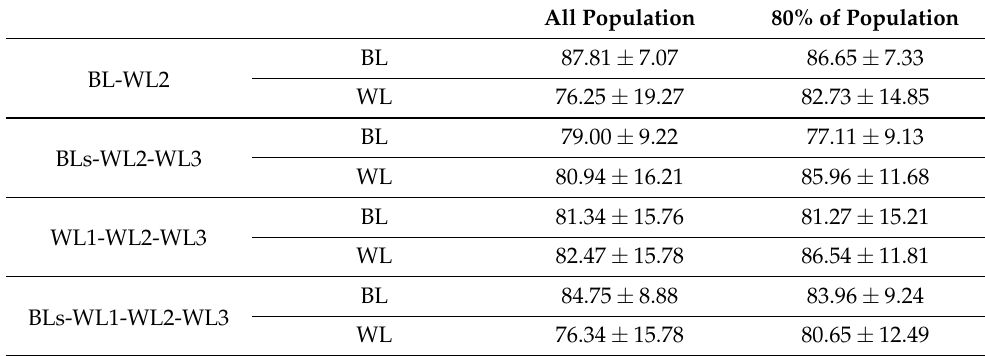
Table 2. Feature projector model